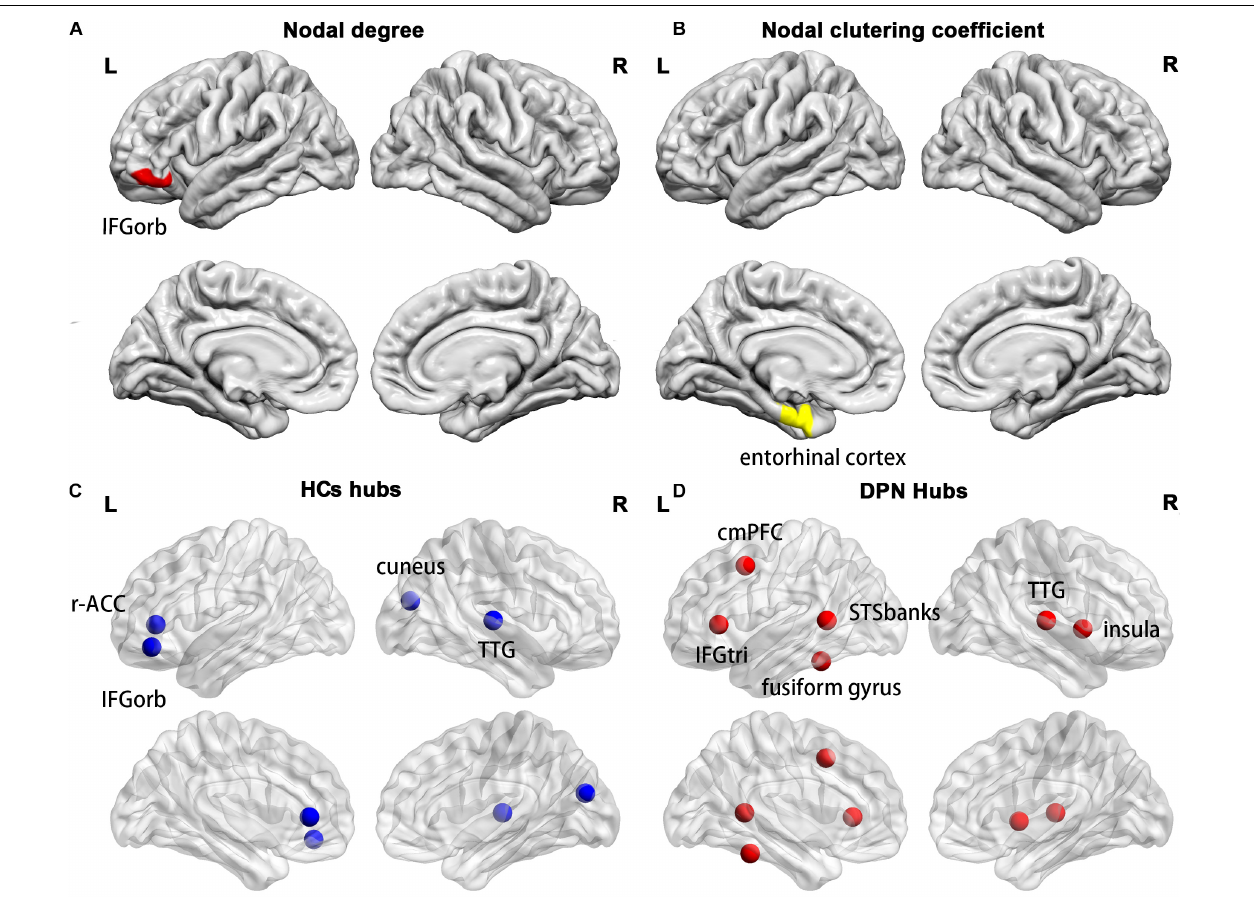
FIGURE 5 | Cortical regions with a decreased nodal degree in the left pars orbitalis (A) and a decreased nodal clustering coefficient in the left entorhinal cortex (B) in DPN patients compared with HCs. The distribution of network hubs in HCs (C) and DPN patients (D) . IFGorb, inferior frontal gyrus pars orbitalis; r-ACC, rostral anterior cingulate cortex; TTG, transverse temporal gyrus; cmPFC, caudal middle prefrontal gyrus; IFGtri, inferior frontal gyrus pars triangularis; STSbanks, banks of the superior temporal